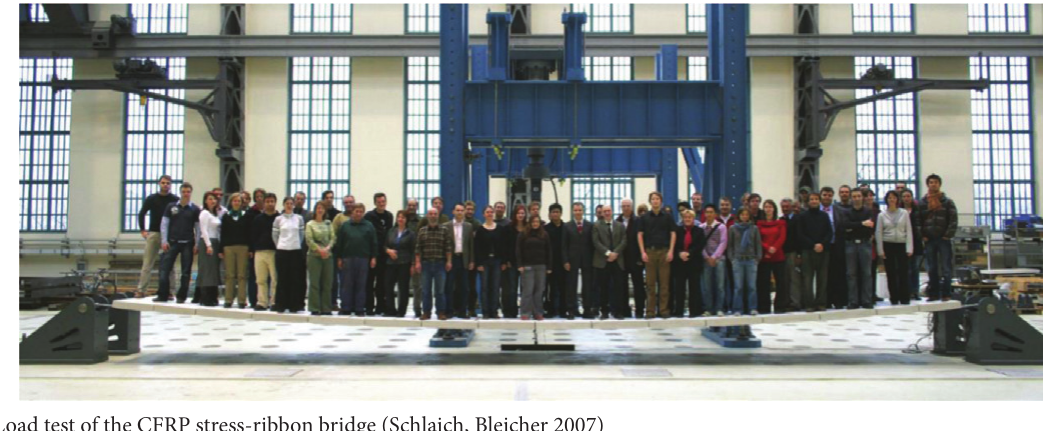
Fig. 1. Load test of the CFRP stress-ribbon bridge (Schlaich, Bleicher 2007)